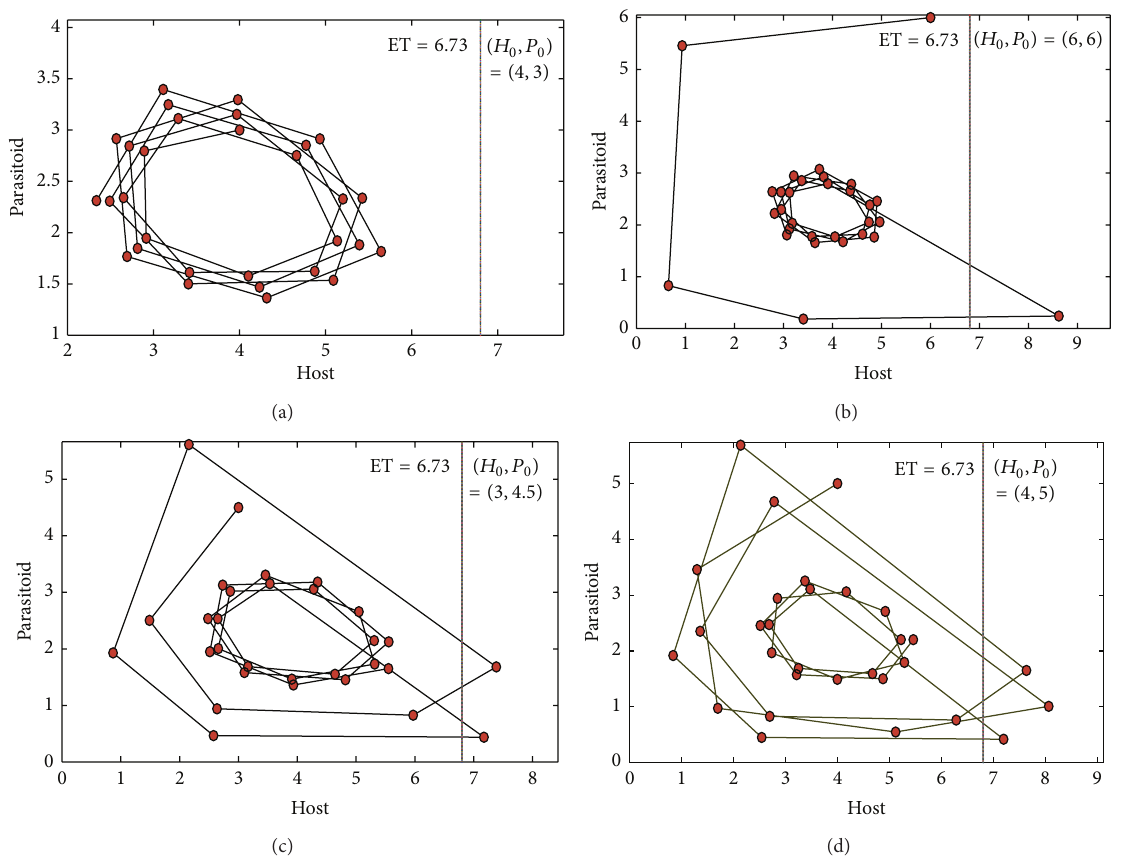
Figure 6: Illustrating the switch effects of initial densities of the host and parasitoid populations of model (3) on IPM. The parameters are fixed as 𝑝 = 0.61 , ET = 6.73 , 𝛽 = 0.4 , 𝜏 = 2 , 𝛼 = 12 , 𝑏 = 1 . The initial densities (𝐻 0 ,𝑃 0 ) in (a)–(d) are (4,3) , (6,6) , (3,4.5) , and (4,5) ,